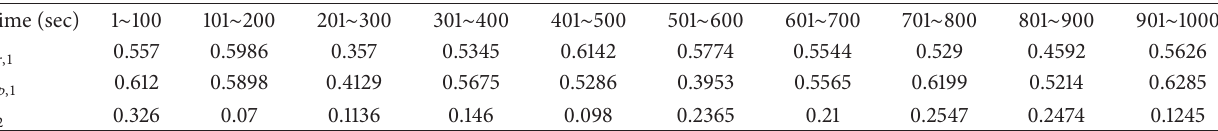
Table 3: Estimated gain parameters for PSO based adaptive 𝛼 - 𝛽 - 𝛾 filter.